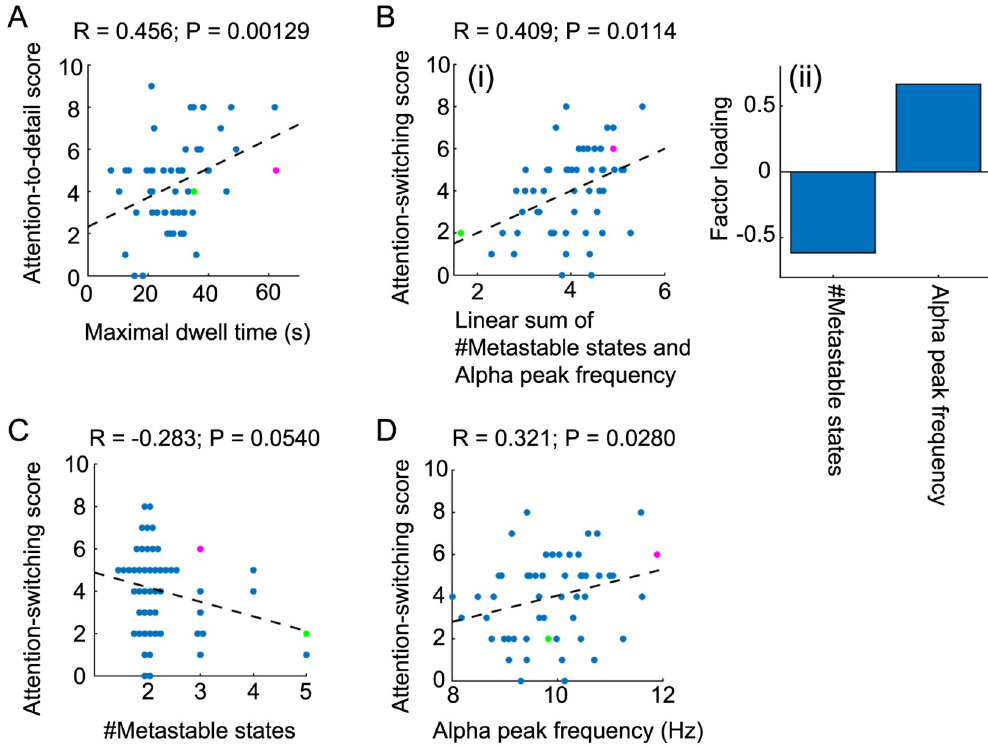
Fig 6. Correlations between delta-alpha PAC dynamics and attention-related AQ subscores. (A) Scatter plot of the attention-to-detail score against maximal dwell time. (B) Scatter plot of the attention-switching score against the linear sum of the number of states and the alpha-band peak frequency (i) with corresponding factor loadings (ii). (C, D) Scatter plots of the attention-switching score against the number of states and the alpha-band peak frequency, respectively. In each panel, the circles in magenta and green correspond to the representative individual delta-alpha PAC dynamics, as depicted in Fig 4A to 4E and 4F to 4J, respectively. The dotted line in each panel indicates the fitted regression line.